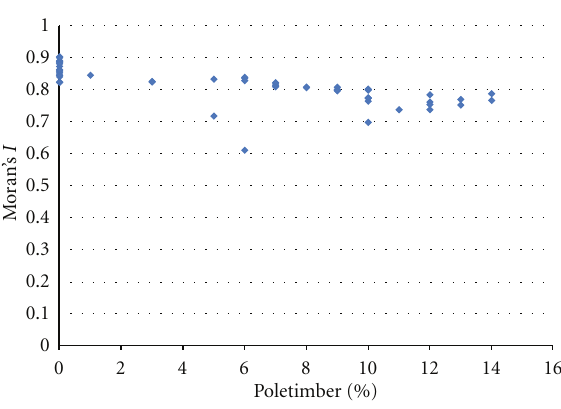
Figure 16: Moran’s I versus sawtimber (bounds